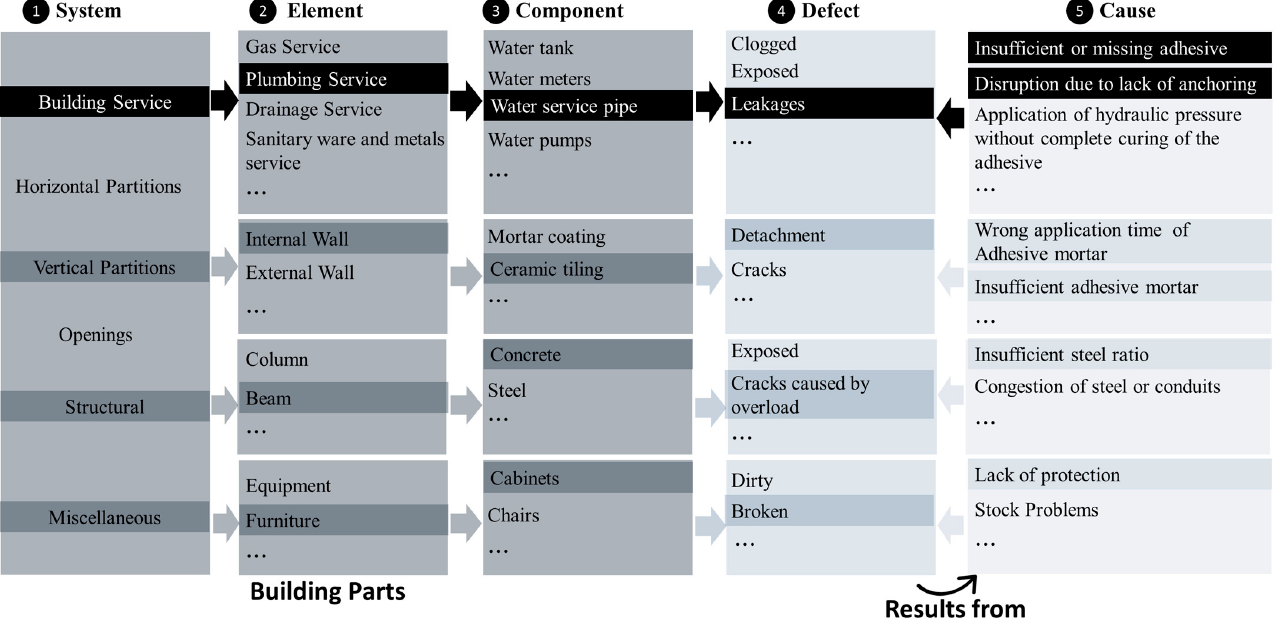
Figure 5. Defect Classification System.